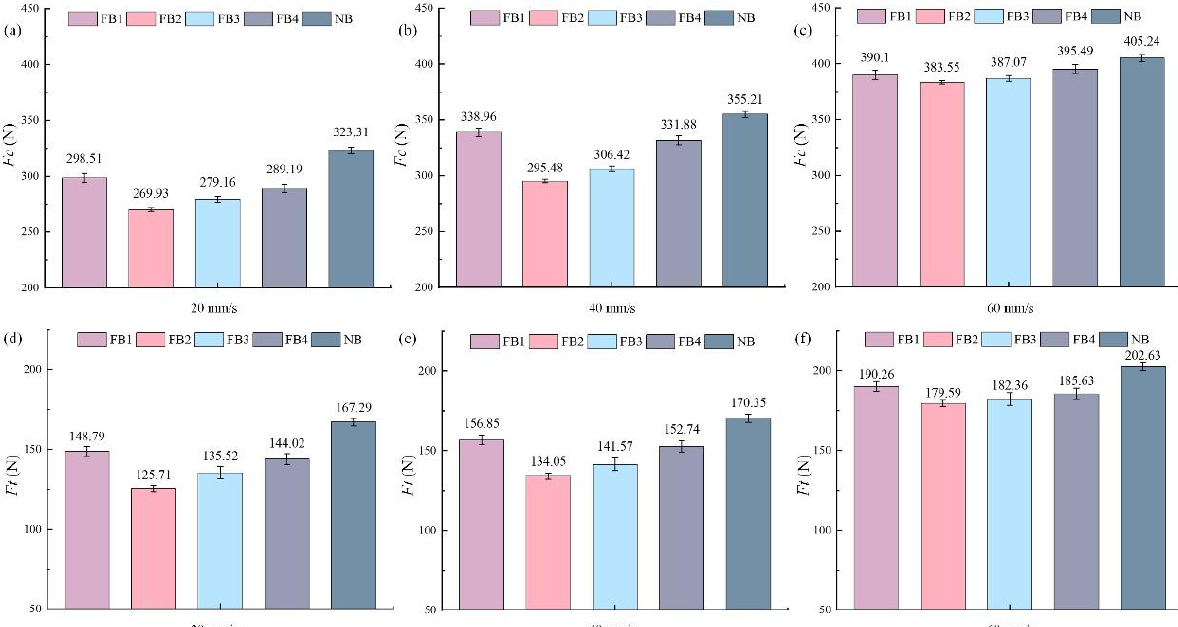
Figure 4. Two-dimensional equilibrium force system of the flocked broaches.